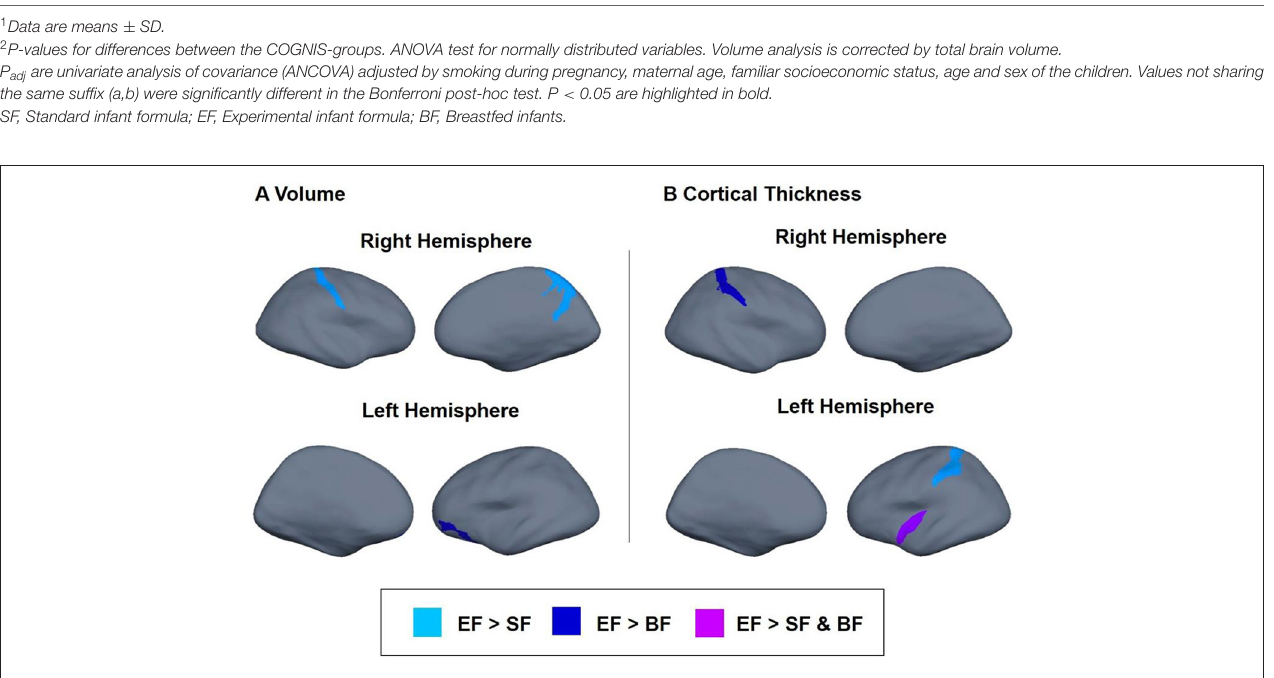
FIGURE 2 | Differences in brain volume (A) and cortical thickness (B) between children participating in the COGNIS study at 6 years of life. Analysis adjusted by smoking during pregnancy, maternal age, familiar socioeconomic status, age, and sex of the children. Brain volume analysis was also corrected for total brain volume. Experimental infant formula (EF) > Standard infant formula (SF) (light blue); EF > BF (dark blue); and EF > SF and EF > BF (purple). SF, Standard infant formula; EF, Experimental infant formula; BF, breastfed